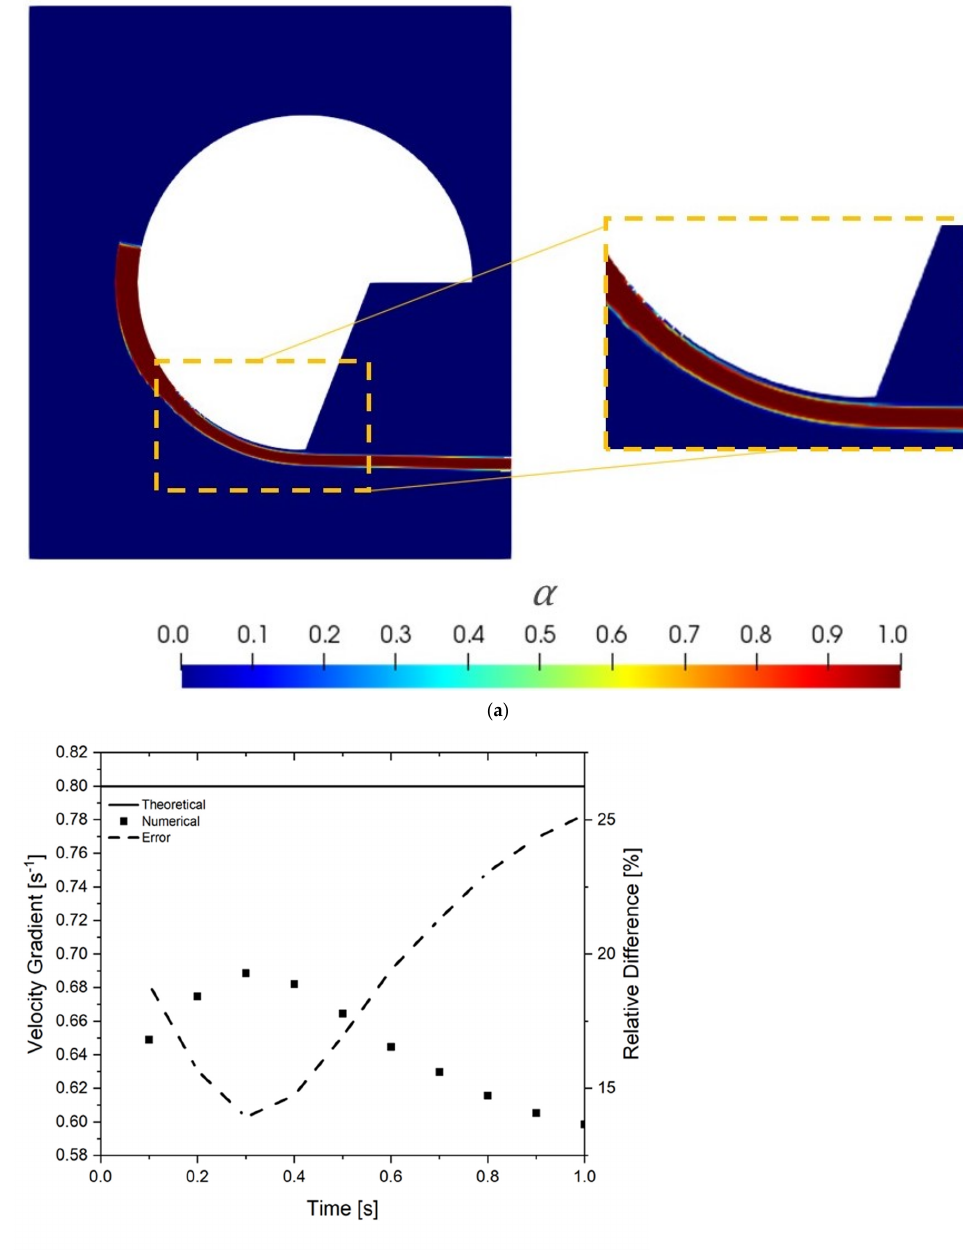
Figure 3. Modelling results using the interFoam solver with G1: ( a ) phase indicator distribution, showing the air penetration problem, ( b ) comparison of the numerical and theoretical average normal velocity gradient at the symmetry plane for the sample ( 𝛼 > 0.5).